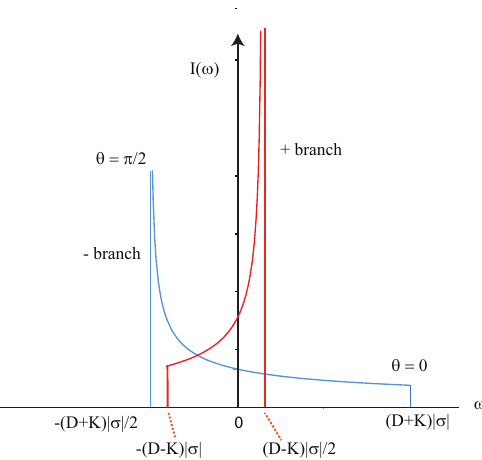
Figure 11. Calculated NMR absorption line shape for long-range Pa3 ordering for pure solid 15 N 2 . The line consists of two asymmetric Pake doublets.